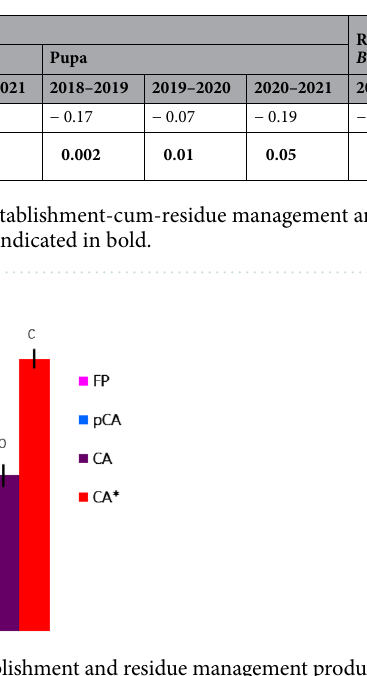
Figure 5. Effect of different tillage cum crop establishment and residue management production systems on rice mealybug, Brevennia rehi infestation on paddy tillers from 2015 to 2017. Bars with different letters indicate significant differences among production systems (LSD; P < 0.05). * CA-based production system with ZTDSR- Mustard (ZT)-spring maize (ZT)